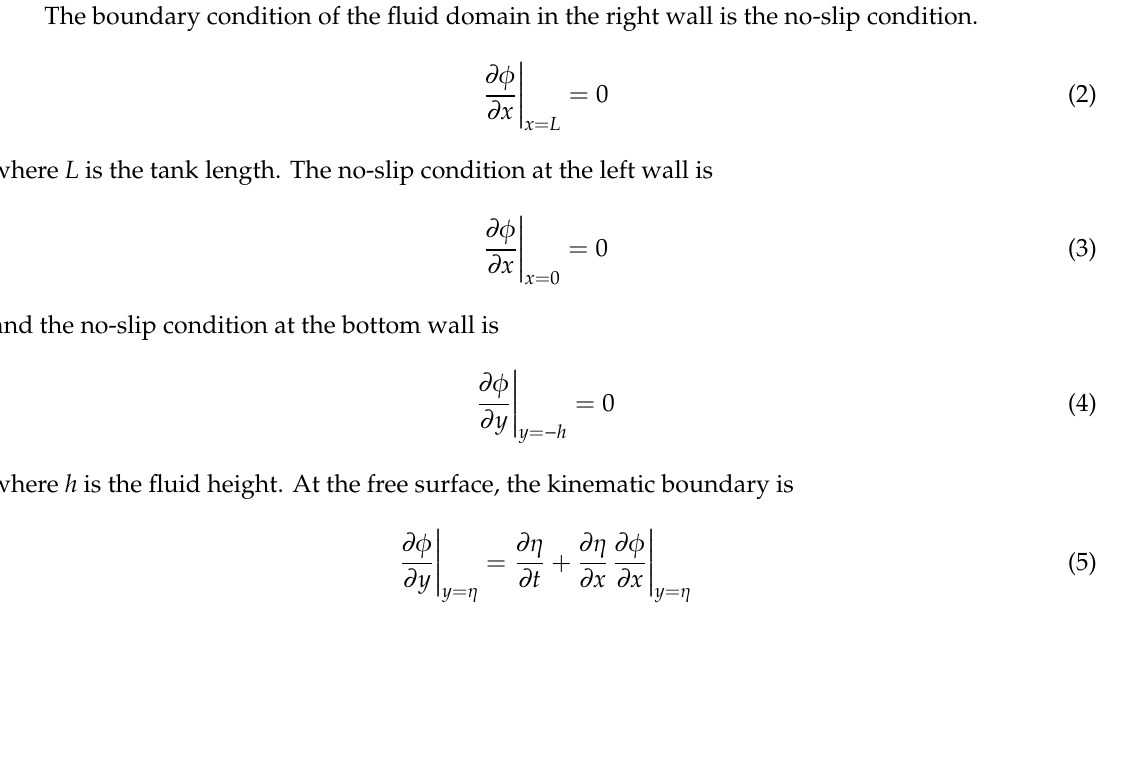
Figure 1. Diagram of fluid-vessel interaction with its cross section.